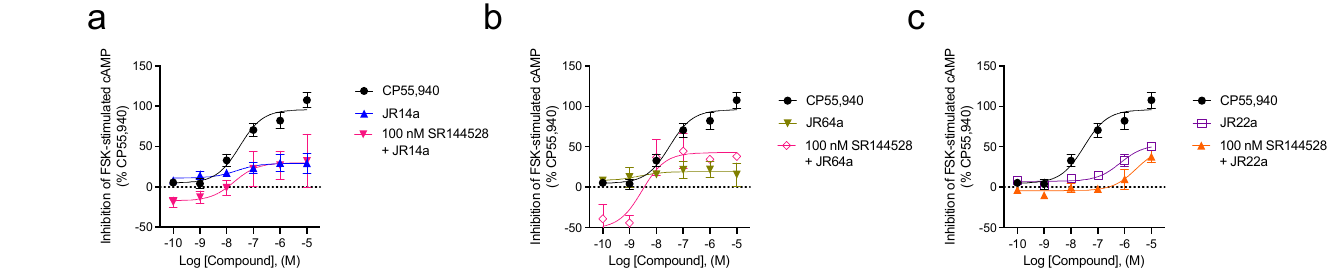
Figure 4. CB2R ‐ dependent inhibition of FSK–stimulated cAMP CHO cells stably expressing h CB2R. cAMP inhibition data are expressed as the %CP55,940 response. Cells were treated with ligands simultaneously, as indicated. Addition of 100 nM SR144528 to JR14a ( a ), JR64a ( b ), or JR22a ( c ). Data were fitted to a nonlinear regression (three ‐ parameter models, GraphPad v. 9.0). Data are mean ± S.E.M. 3 or more independent experiments performed in triplicate. Specific n values and data from these graphs are presented in Table 1.